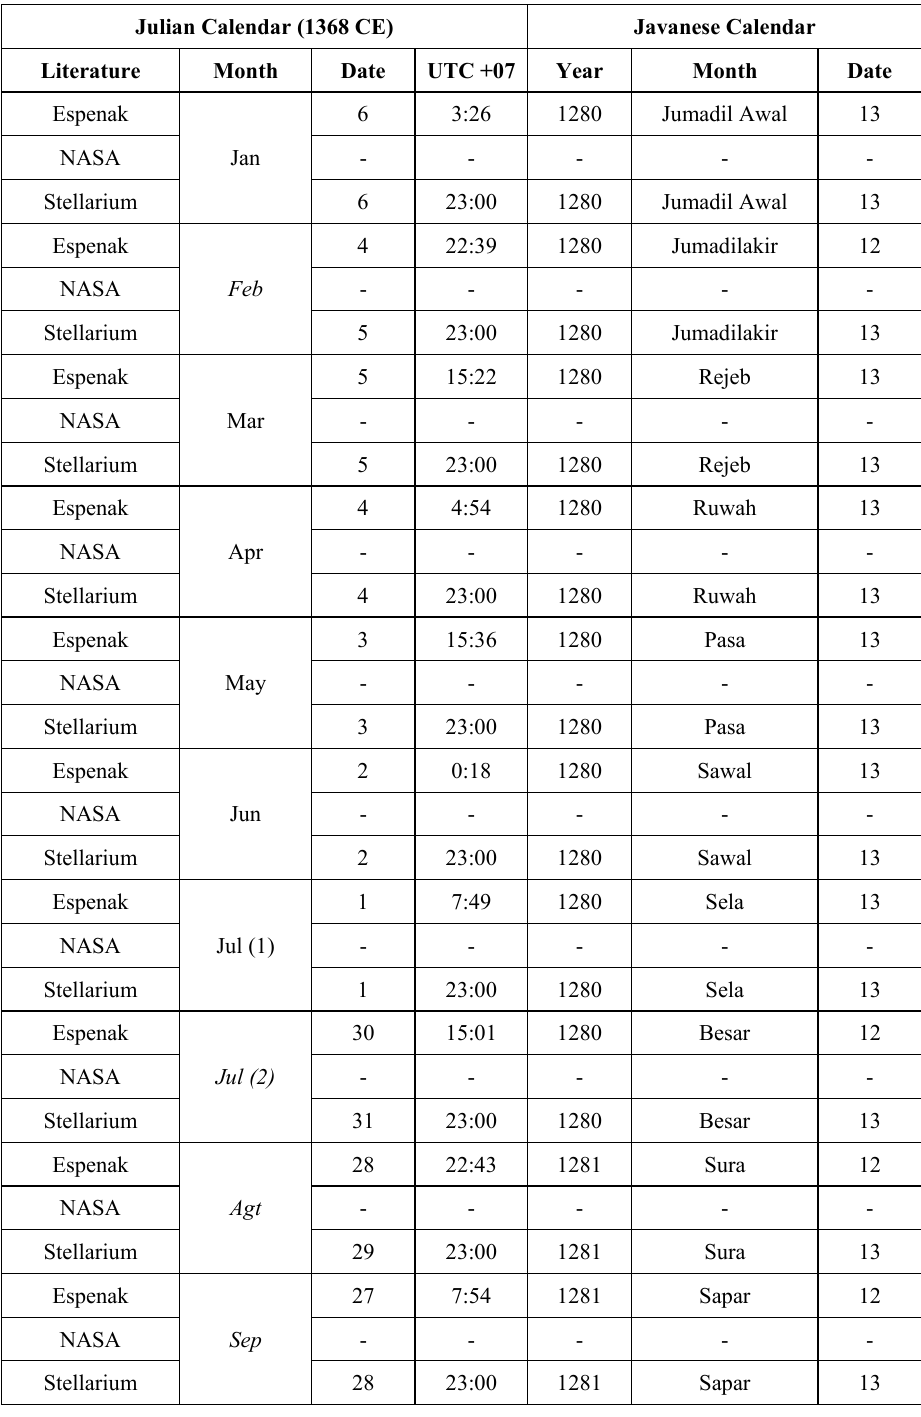
Table 3. Date Conversion from Julian Calendar to Javanese Calendar for 1368 CE with a